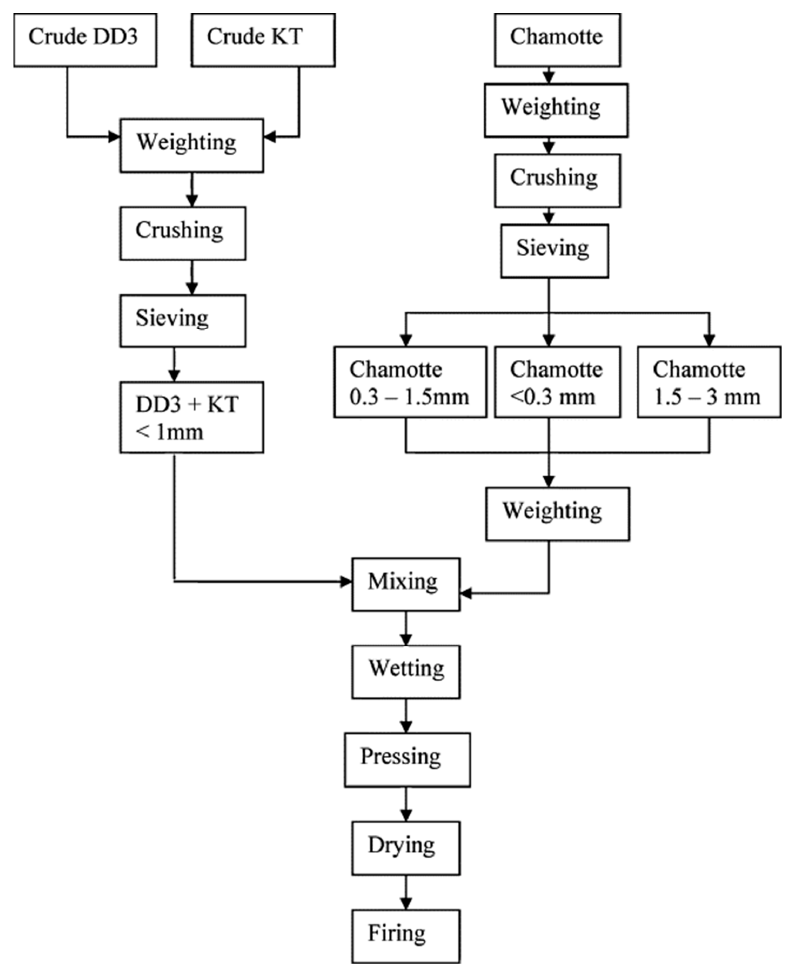
Figure 3. Schematic representation of the manufacturing process of the BSAA bricks [41].